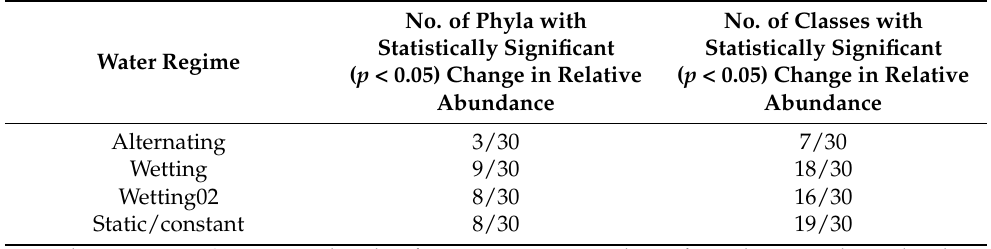
Table 1. Number of taxonomic groups with significant change in relative abundance under four black soil water